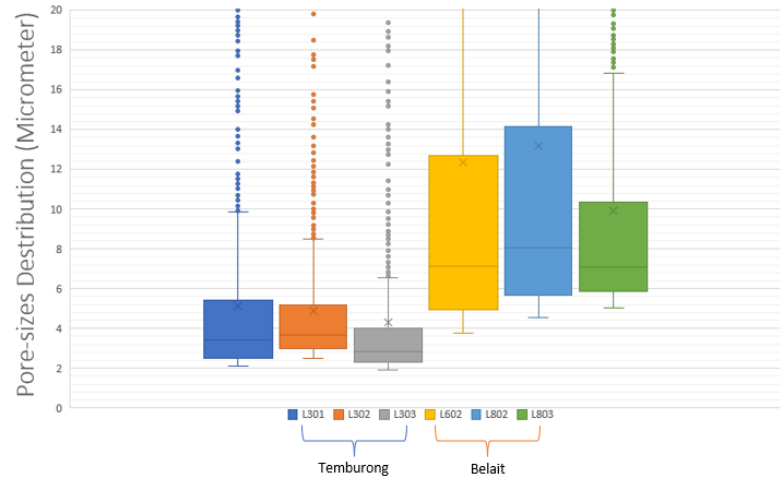
Figure 20. A box plot of 6 samples from Temburong and Belait Formations. Table 3. Grain size distribution data.